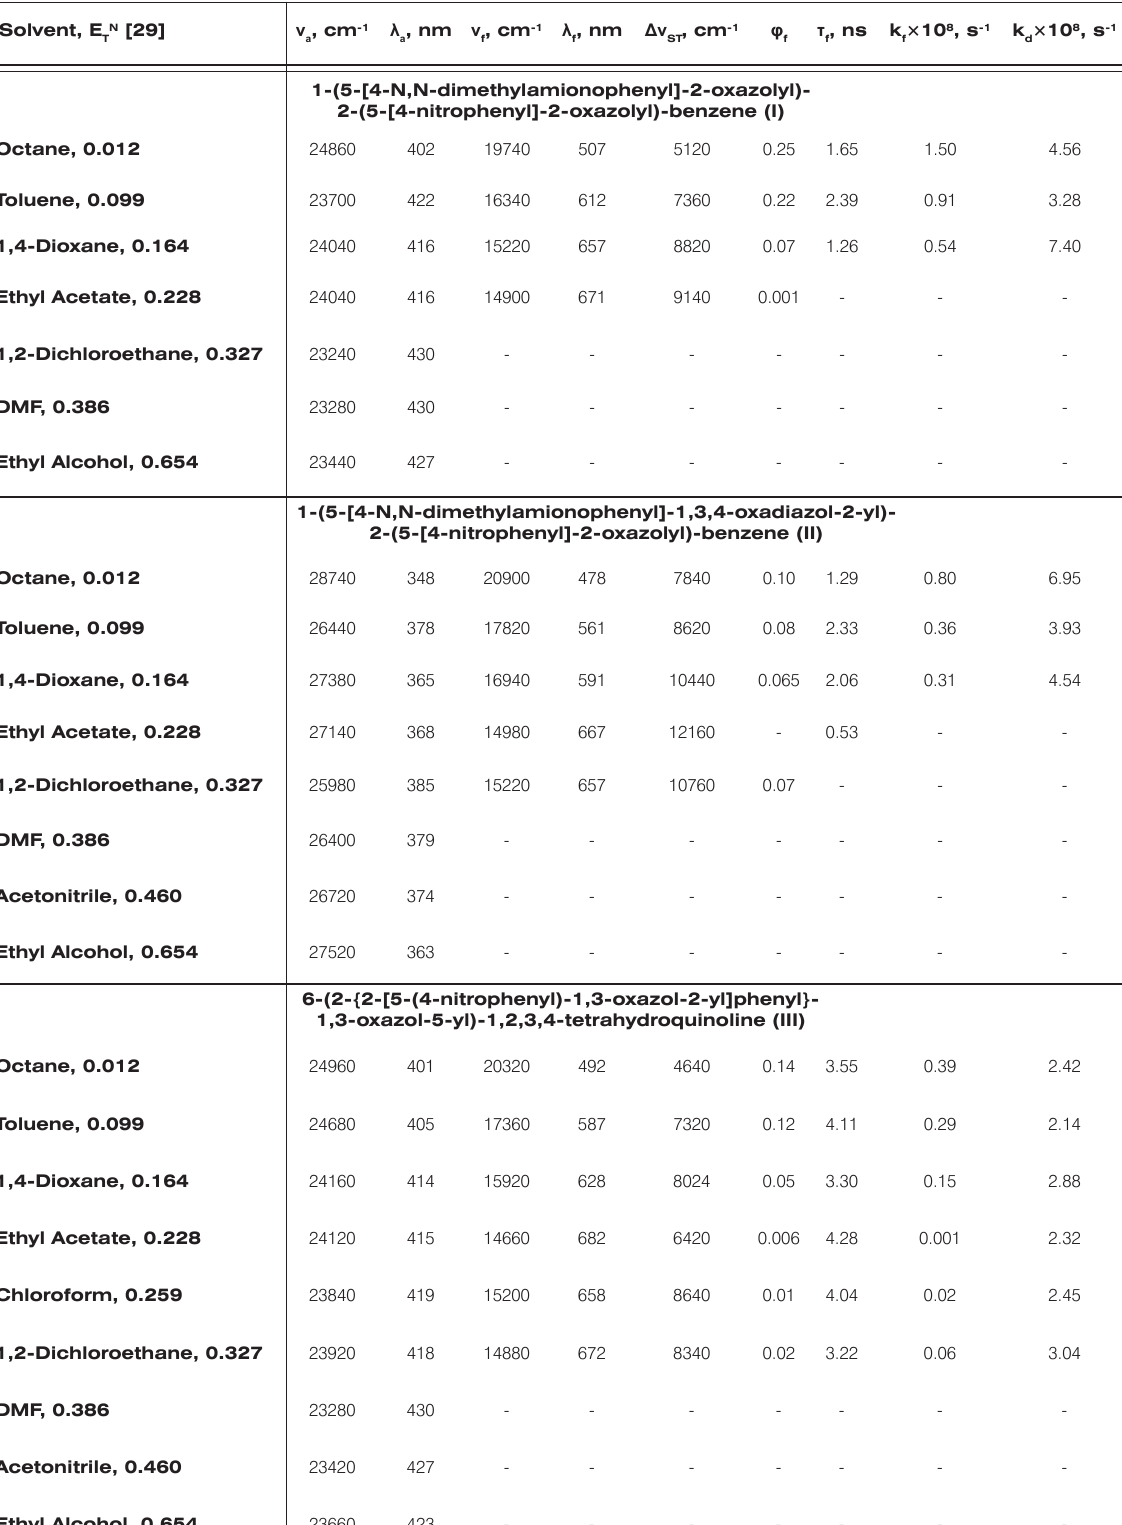
Table 1. Spectral and photophysical properties of the dialkylamino/nitro substituted ortho-analogs of POPOP (I-III) in solvents of different polarity. Solvent, E TN